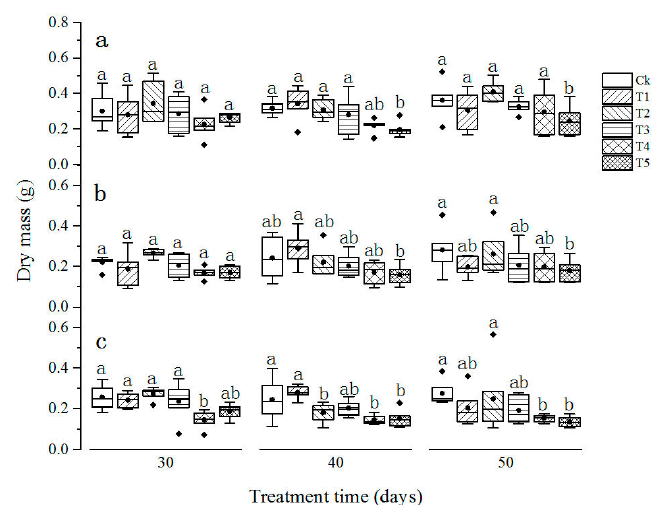
Figure 2. Dry masses of leaf ( a ), stem ( b ) and root ( c ) of L. olgensis seedlings at different concentrations of graphene. Values followed by the same letter for the same days are not significantly different at p < 0.05. Ck, T1, T2, T3, T4, and T5 represent 0, 25, 50, 100, 250, and 500 mg L -1 graphene treatments, respectively.